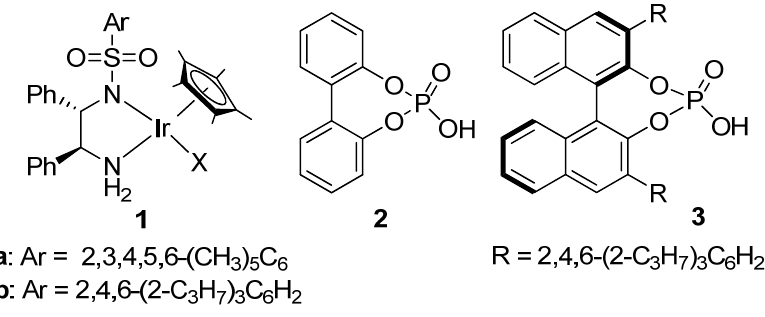
Figure 2. Catalyst 1 and phosphoric acids 2 and 3 used in this